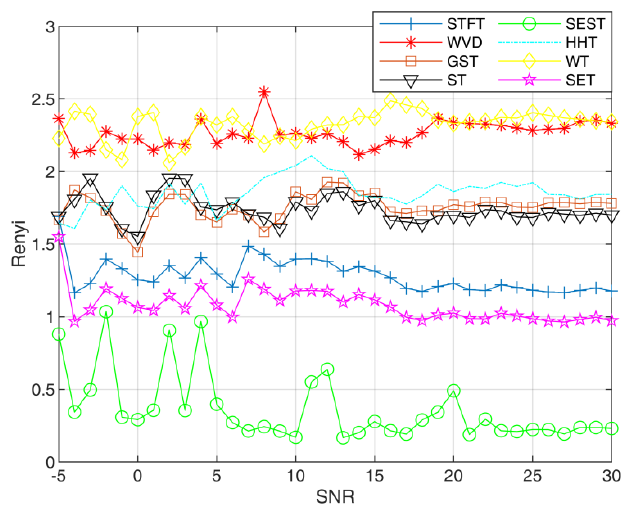
Figure 7. Rényi entropy evaluation results of rotor vibration fault signal with noise. Figure 7. R é nyi entropy evaluation results of rotor vibration fault signal with noise.